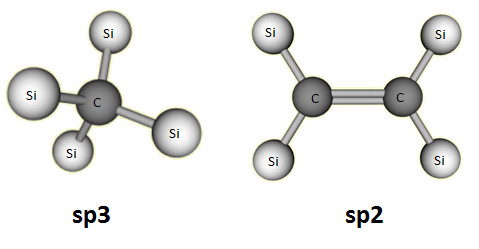
sp3-sp2 hybridisation.